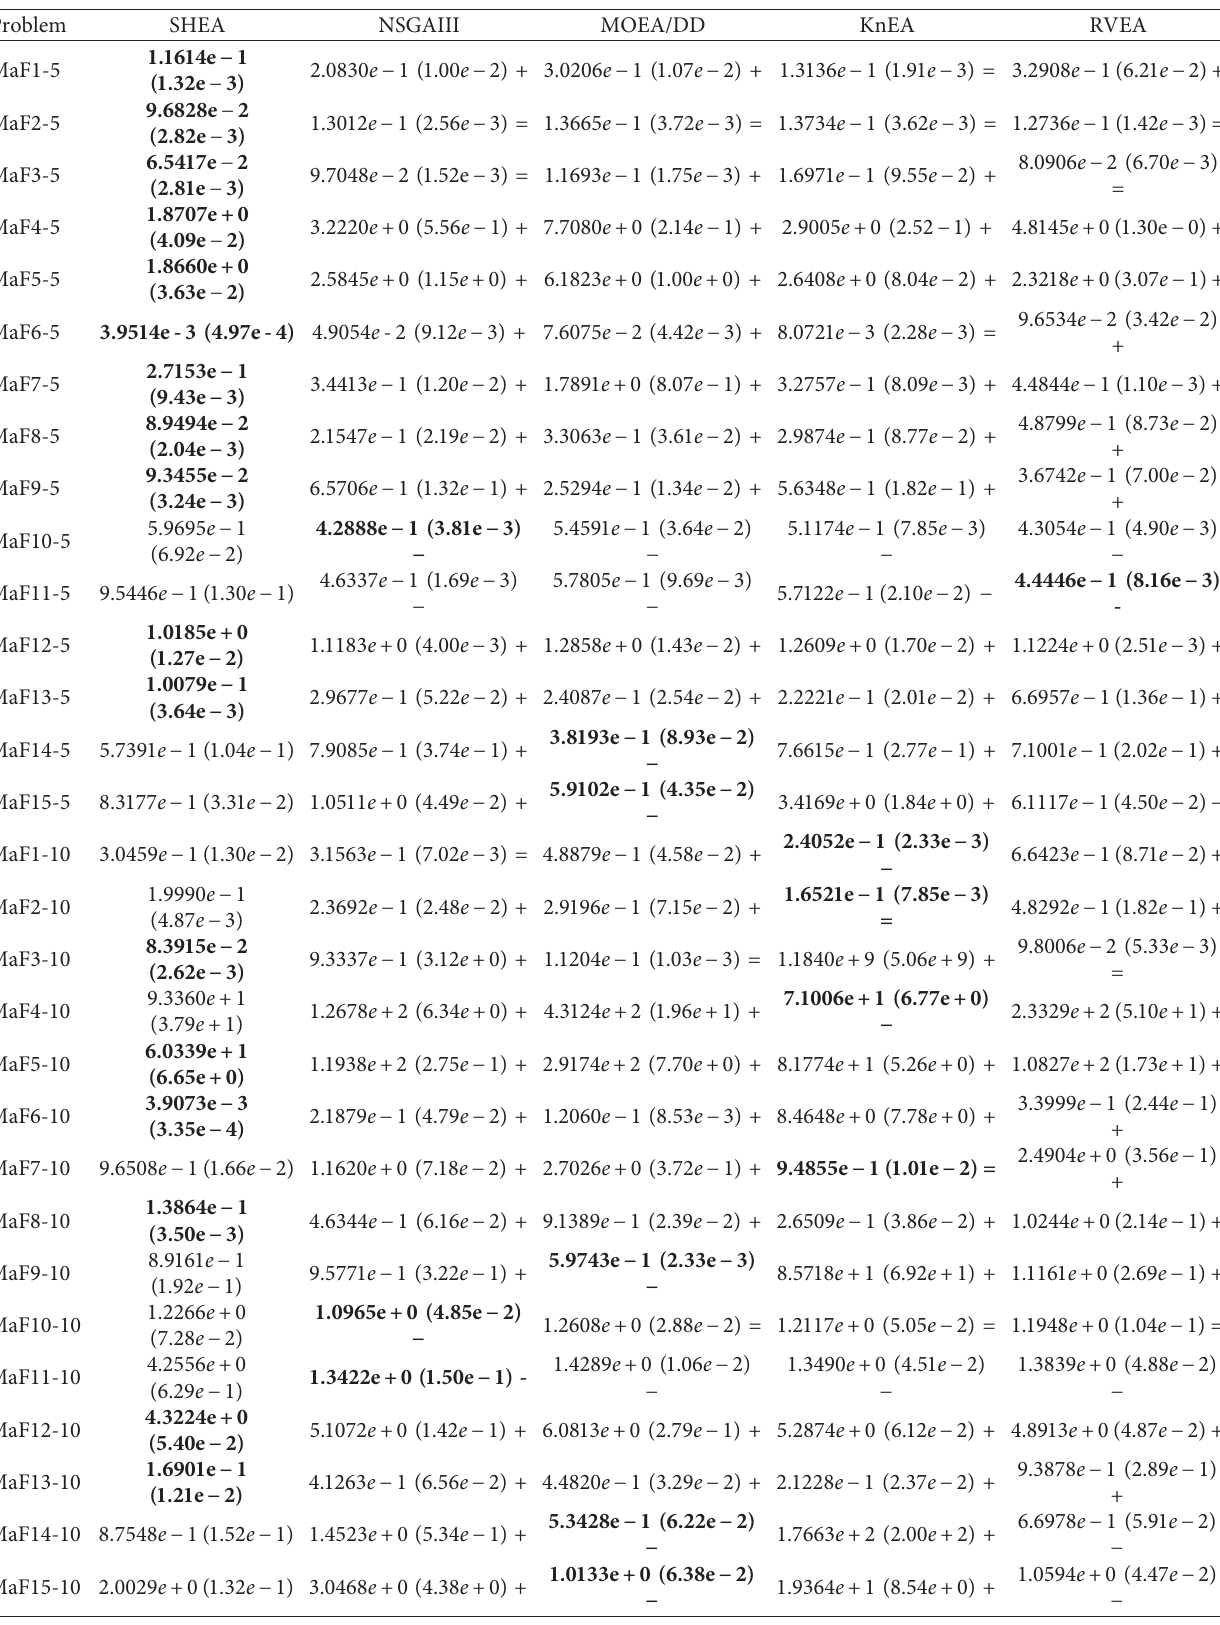
Table 1: The mean and standard deviation values of IGD obtained by SHEA, NSGAIII, MOEA/DD, KnEA, and RVEA while “+,” “ � ,” “ − ” mean SHEA is better than, the same as, and worse than the compared